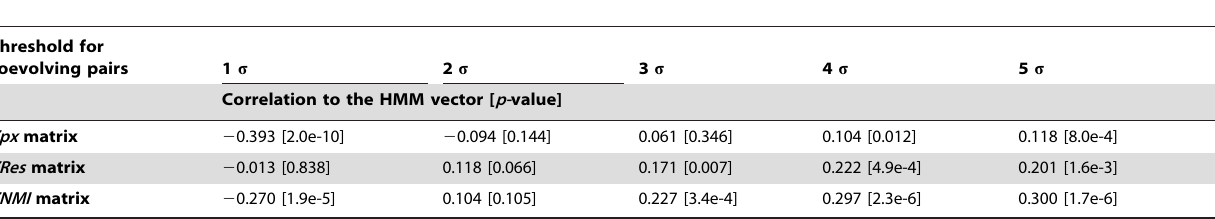
Table 1. Correlation coefficients between the histogram vectors derived from the MI matrices and the HMM vector of Figure 1A.